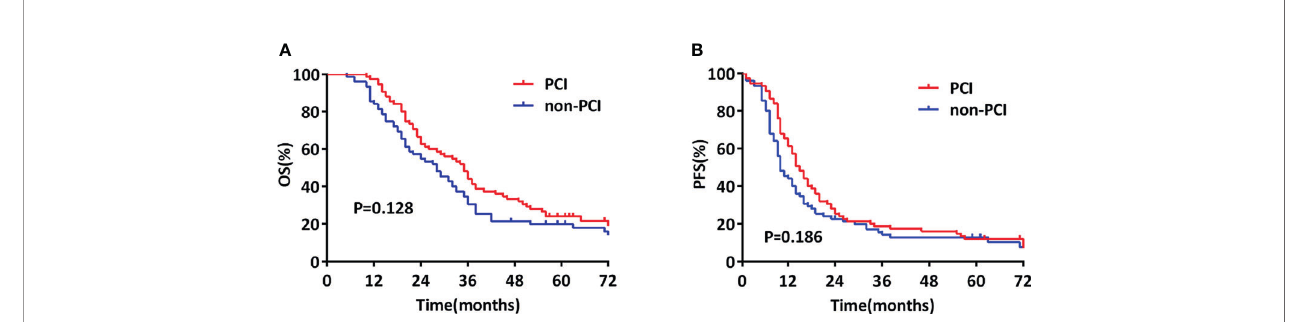
FIGURE 1 | Comparison of overall survival (OS) (A) and progression-free survival (PFS) (B) of propensity-matched patients with limited-stage small cell lung cancer who did and did not undergo prophylactic cranial irradiation (PCI).